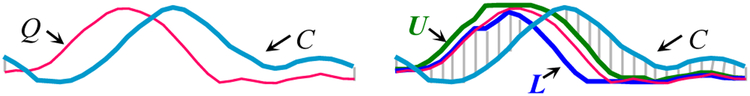
left) The LB_KimFL lower bound is O(1) and uses the distances between the First (Last) pair of points from C and Q as a lower bound. It is a simplification of the original LB_Kim [21]. right) The LB_Keogh lower bound is O(n) and uses the Euclidean distance between the candidate sequence C and the closer of {U,L} as a lower bound